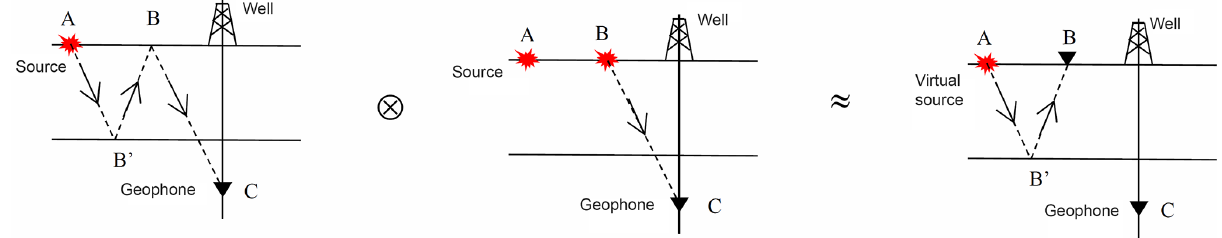
Figure 1. Interferometric transformation of VSP data to surface seismic